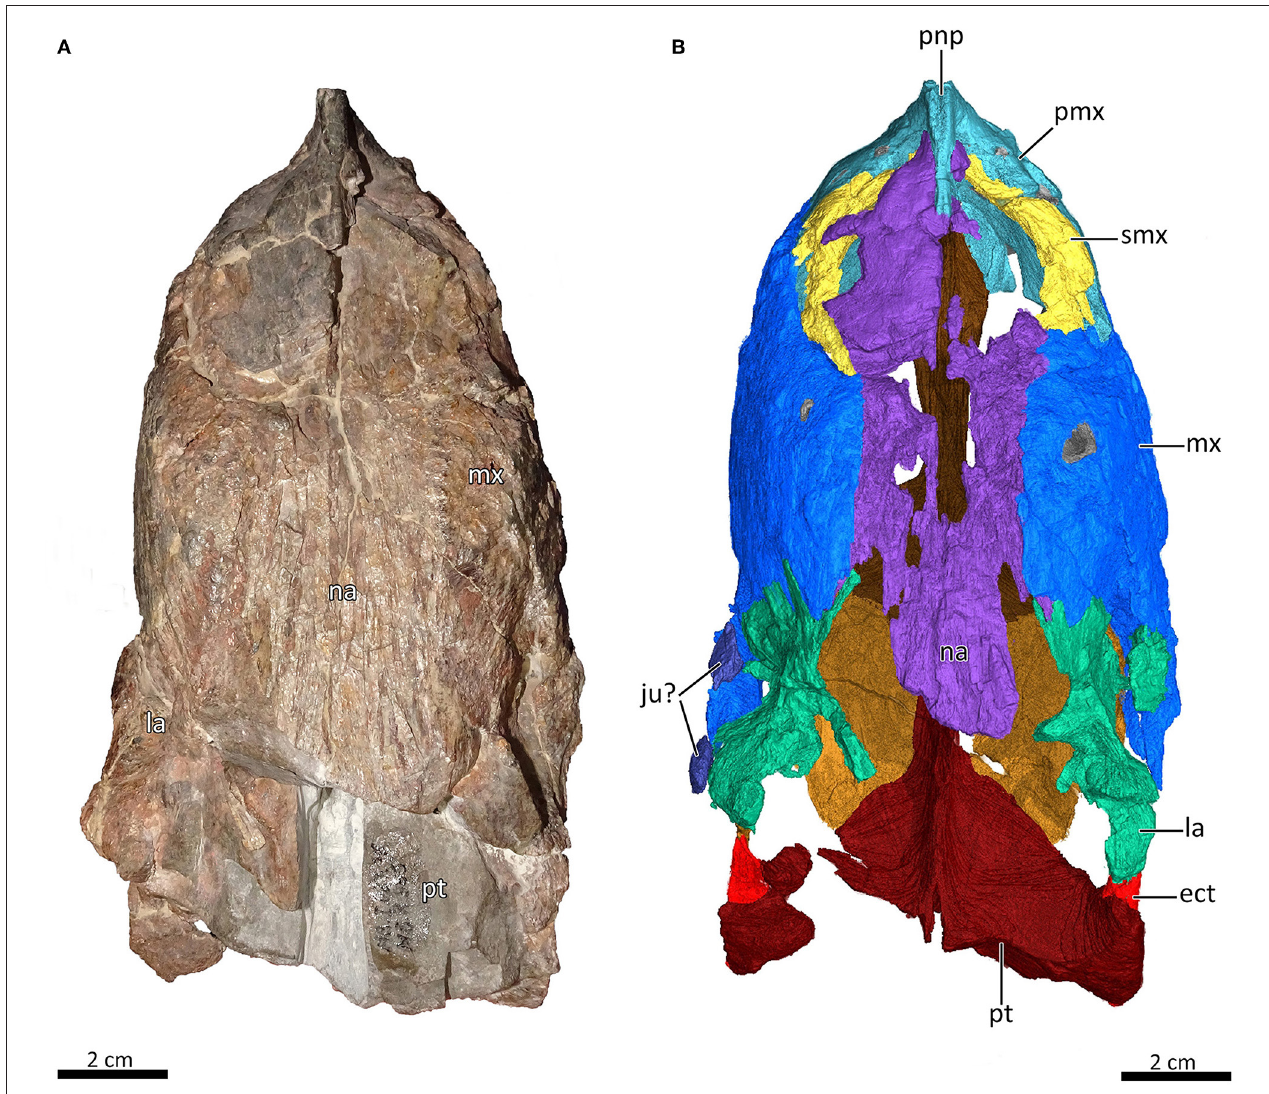
FIGURE 2 | Snout of MB.R.995 in dorsal view. (A) Photograph and (B) 3D reconstruction of the snout. ect, ectopterygoid; ju?, jugal?; la, lacrimal; mx, maxilla; na, nasal; pmx, premaxilla; pnp, prenasal process of the premaxilla; pt, pterygoid; smx,